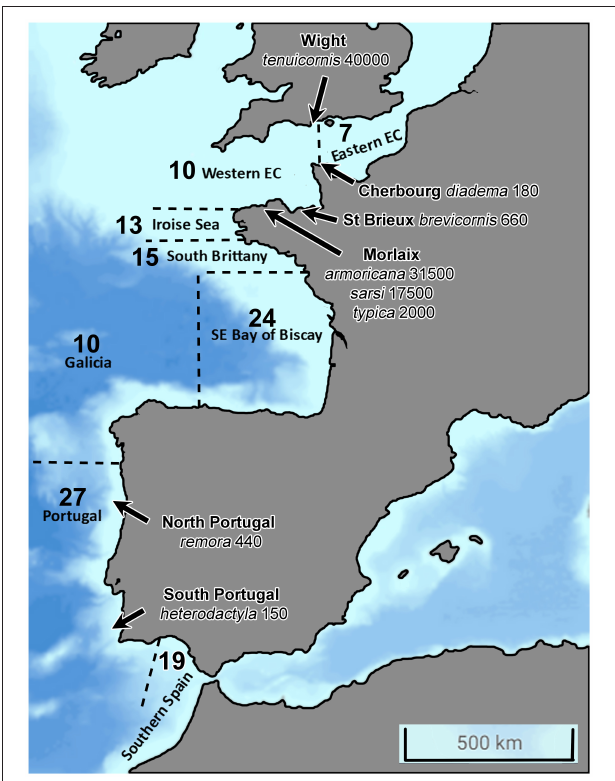
FIGURE 2 | North-eastern Atlantic Coast from the Strait of Gibraltar, South, to the Strait of Dover, North, showing the eight geographical locations under study for the distribution of Ampelisca species. The bold number correspond to the number of Ampelisca species found in the eight areas; the species name and numbers correspond to the maximal abundances per m 2 in different